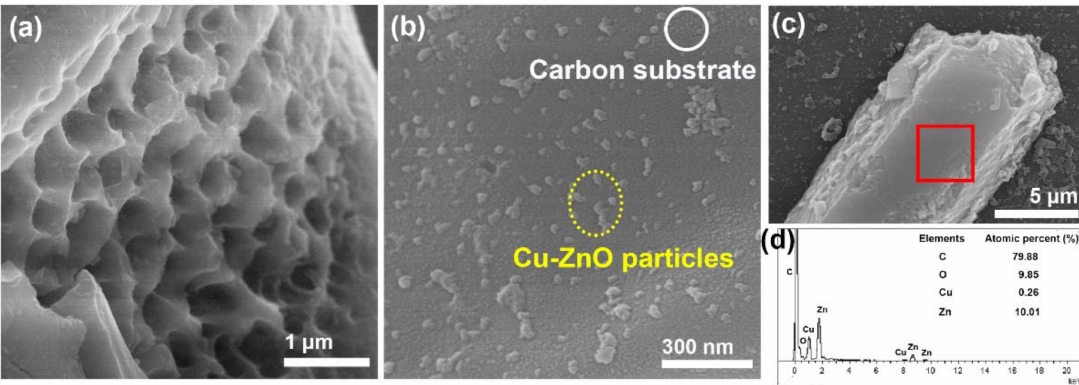
Figure 7. SEM images of the Cu–ZnO@C compound prepared by post-heat-treatment Complex at 600 ◦ C under N 2 . ( a , c ) Low-resolution image; ( b ) high-resolution image; ( d ) Energy dispersive spectrometer (EDS) spectra recorded from the corresponding red rectangular region in ( c